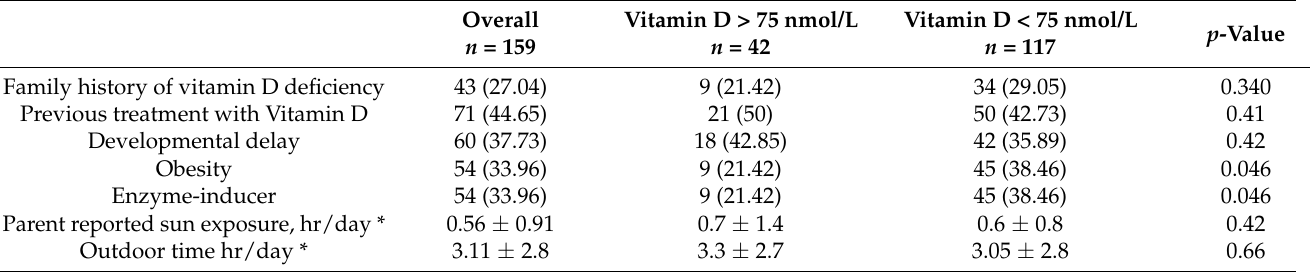
Table 3. Distribution of risk factors predisposing for Vitamin D